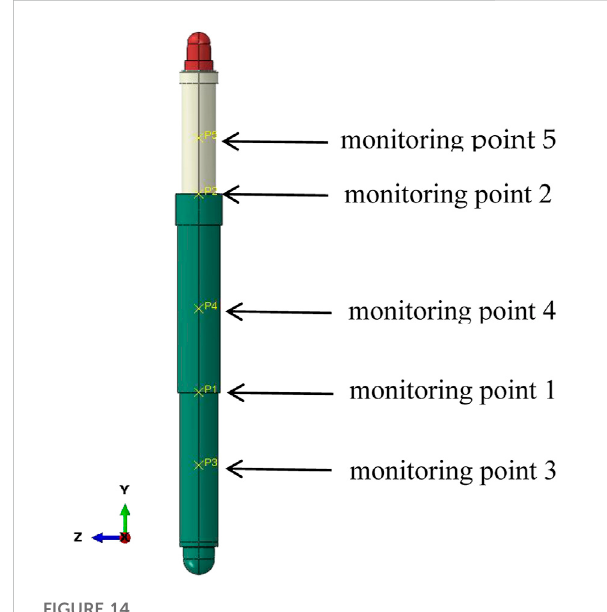
FIGURE 14 Layout of measurement